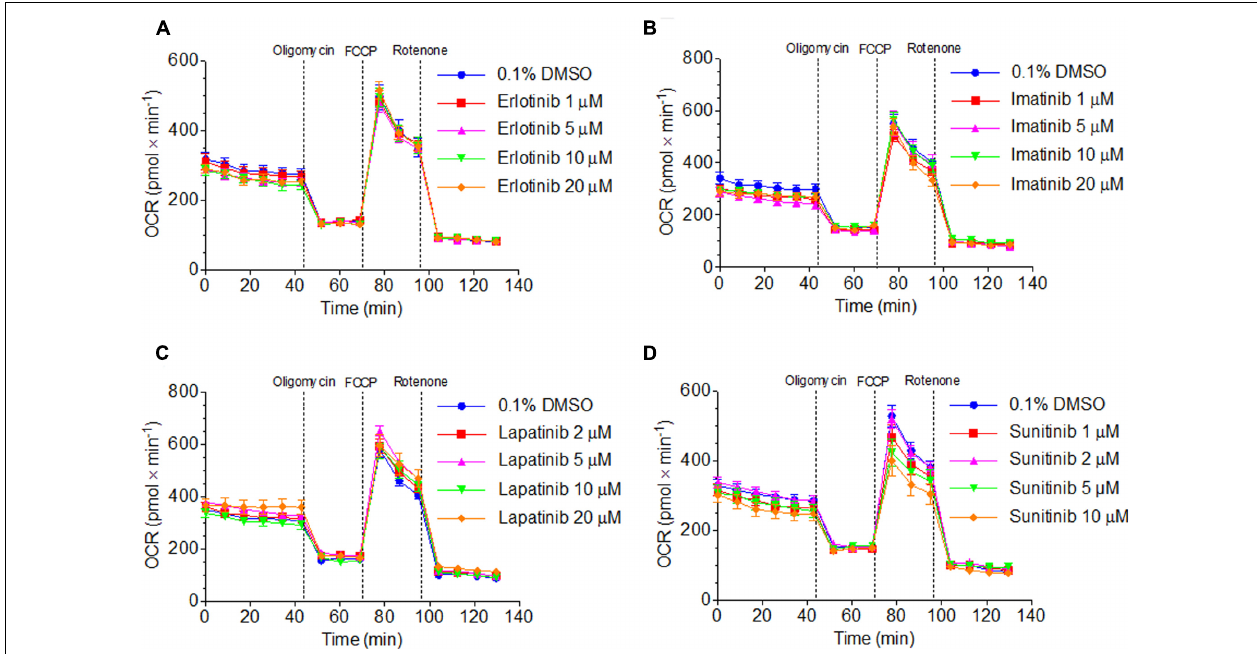
FIGURE 4 | Function of the respiratory chain in HepG2 cells. Oxygen consumption rate after exposure to (A) erlotinib, (B) imatinib, (C) lapatinib or (D) sunitinib for 48 h. Data represent the mean ± SEM of at least three independent experiments.